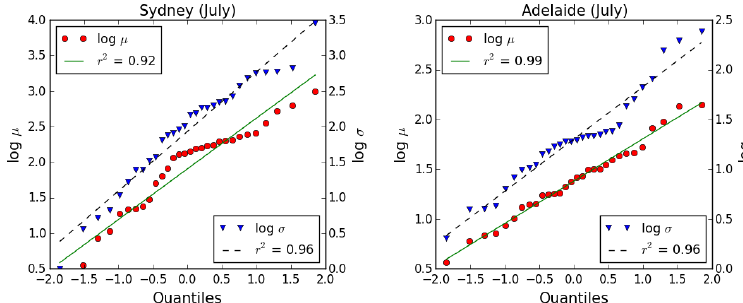
Figure 3. Lognormal probability plots of µ and σ for July (typical of other months).